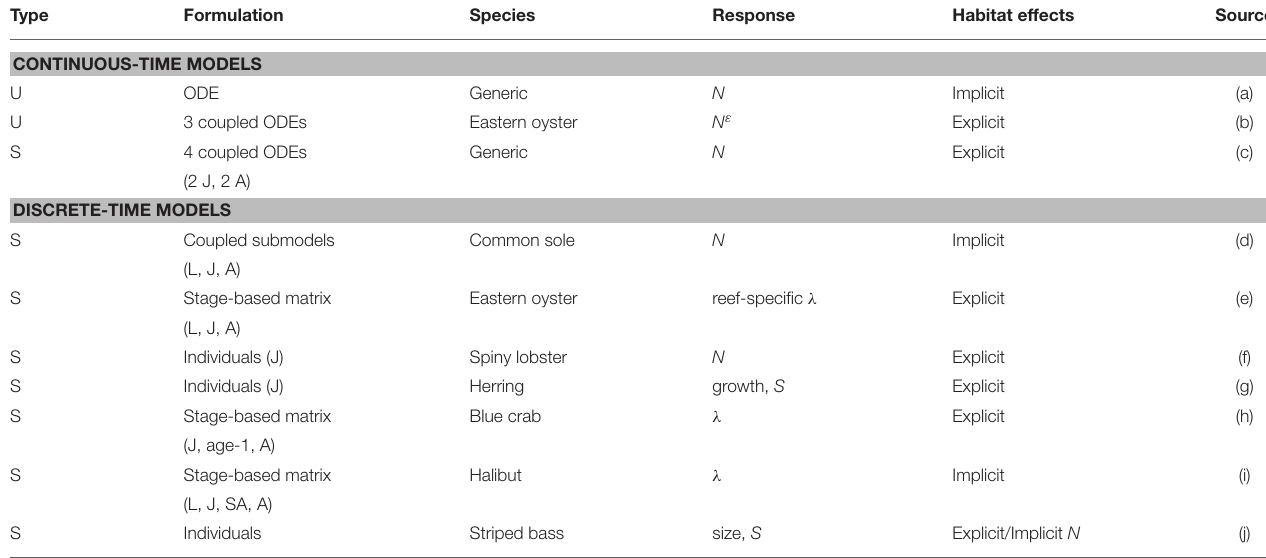
TABLE 1 | Key features of the dynamic models used as